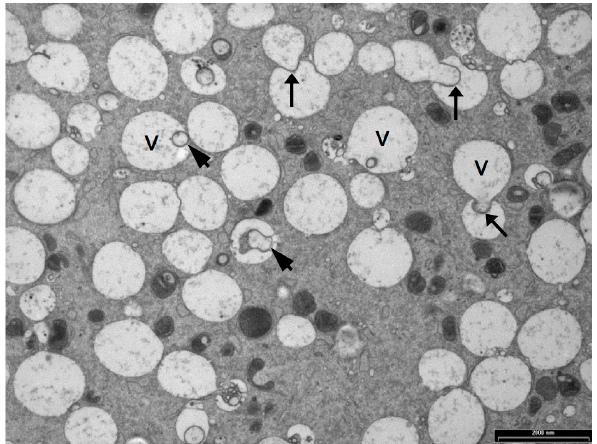
Figure 4. TEM image of the cytoplasm of a sheep oocyte with vesicles (v) containing granular material or membranous structures (arrowheads), and appearing to bud or coalesce with other vesicles (black arrows). Scale bar = 2 μ m.